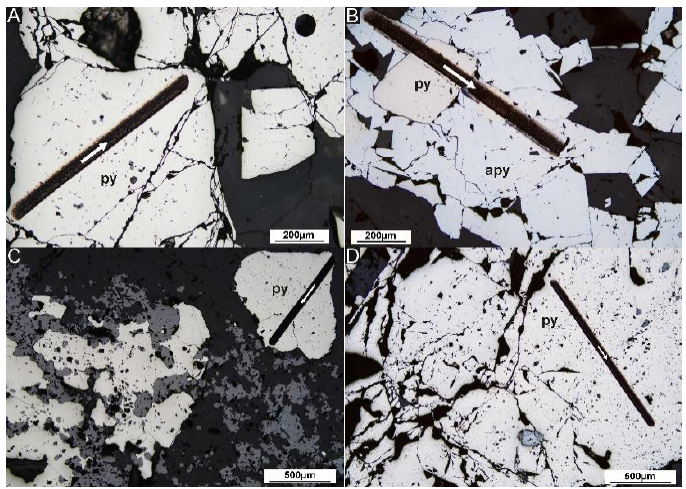
Figure 8. Photomicrographs of the LA-ICP-MS profiles in pyrite from Darasun ( A , B ), Talatui ( C ), and Teremkyn ( D ) ores in reflected light. A—LA-ICP-MS profile through an euhedral pyrite grain from sample 6Vd89. B—profile through pyrite grains in arsenopyrite from sample 6Vd89. C—profile in a distinct anhedral pyrite grain from sample 50-01. D—profile in pyrite aggregate from sample